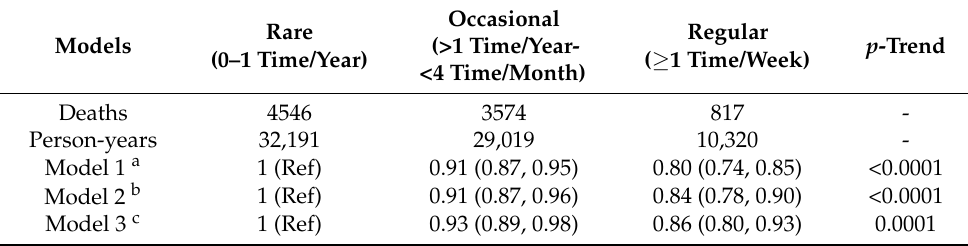
Table 2. Hazard Ratios (95% CI) for mortality according to baseline intake frequency of mushrooms and